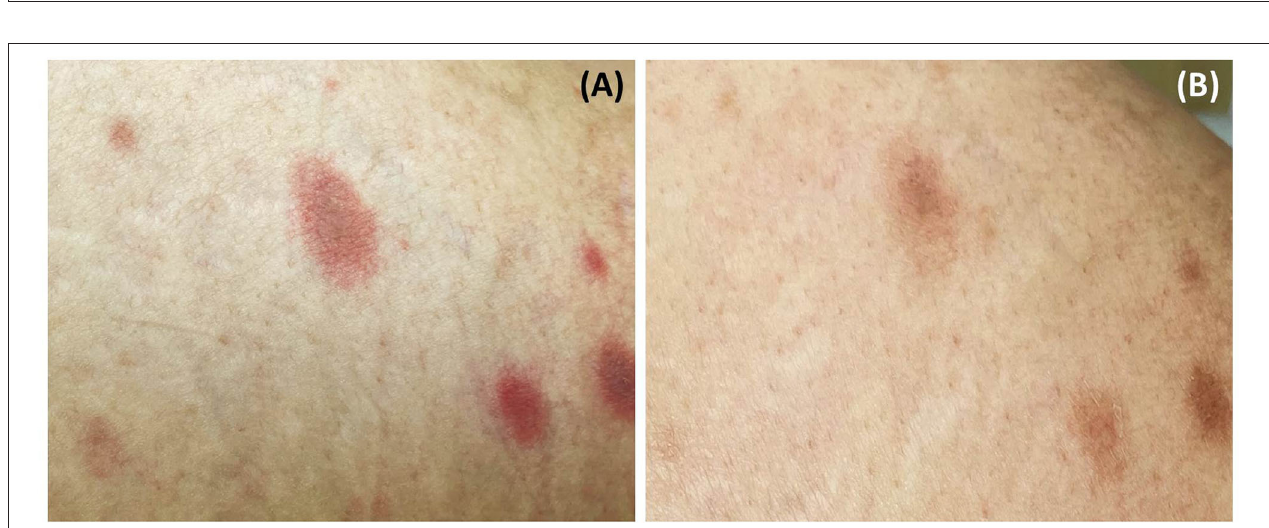
FIGURE 2 | Central dusky-red erythematous on some plaques (A) ; almost all lesions fading with associated post-inflammatory hyperpigmentation after treatment (B) .